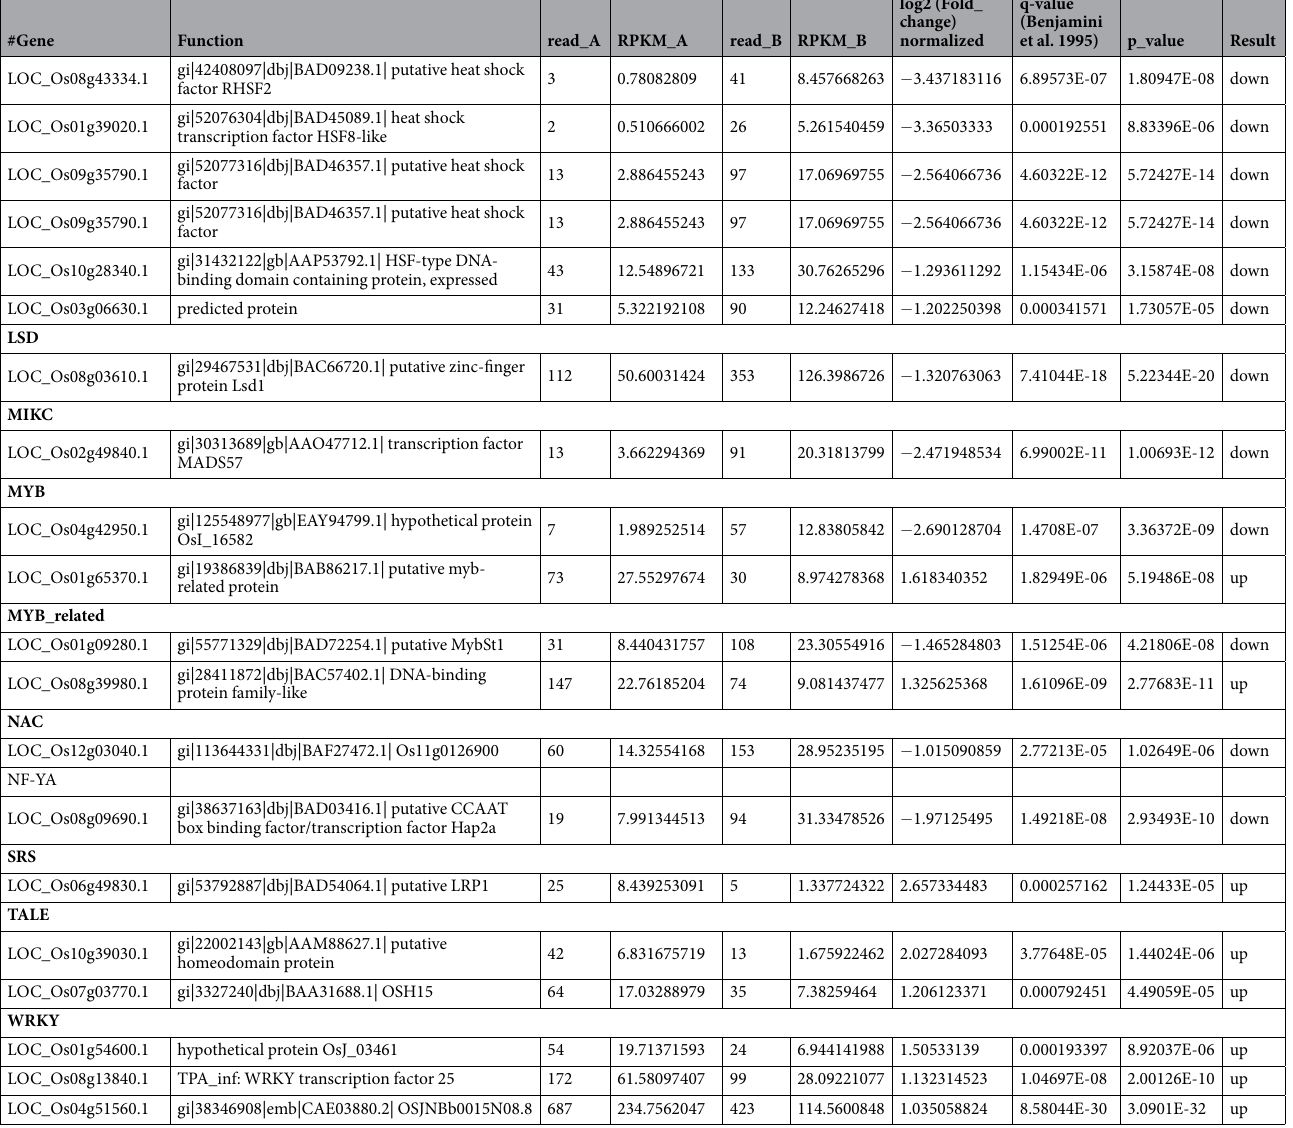
Table 1. The transcription factors were identified in rice root respond to low K +